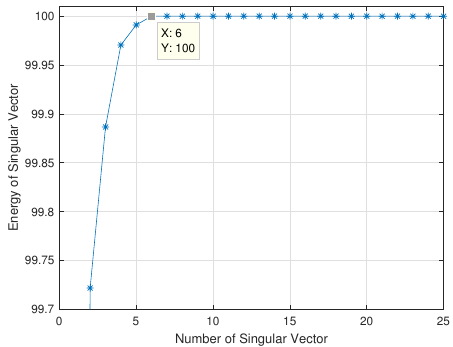
Figure 8. Energy measured in the subspace of the first 100 singular vectors of transformed EEG data, Z